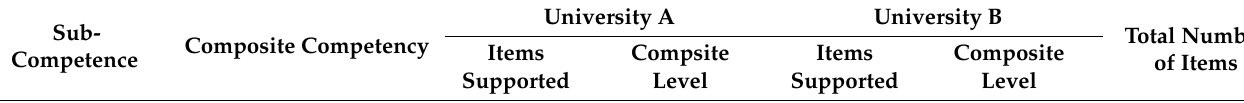
Table 2. Summary hypotheses test (based on Tables 1 and A1, Appendix